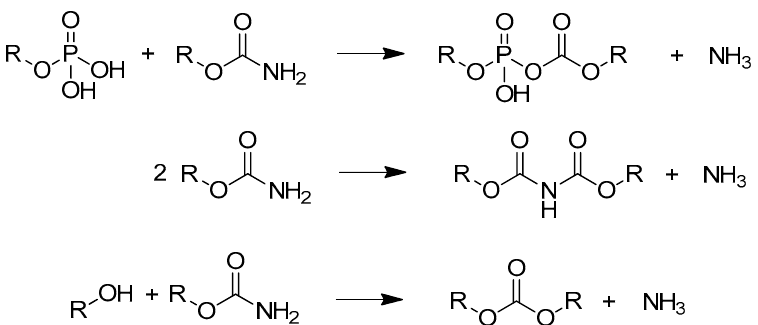
Figure 2. Possible condensation reactions of phosphates and carbamate groups, R = starch, based on [21,22,26].